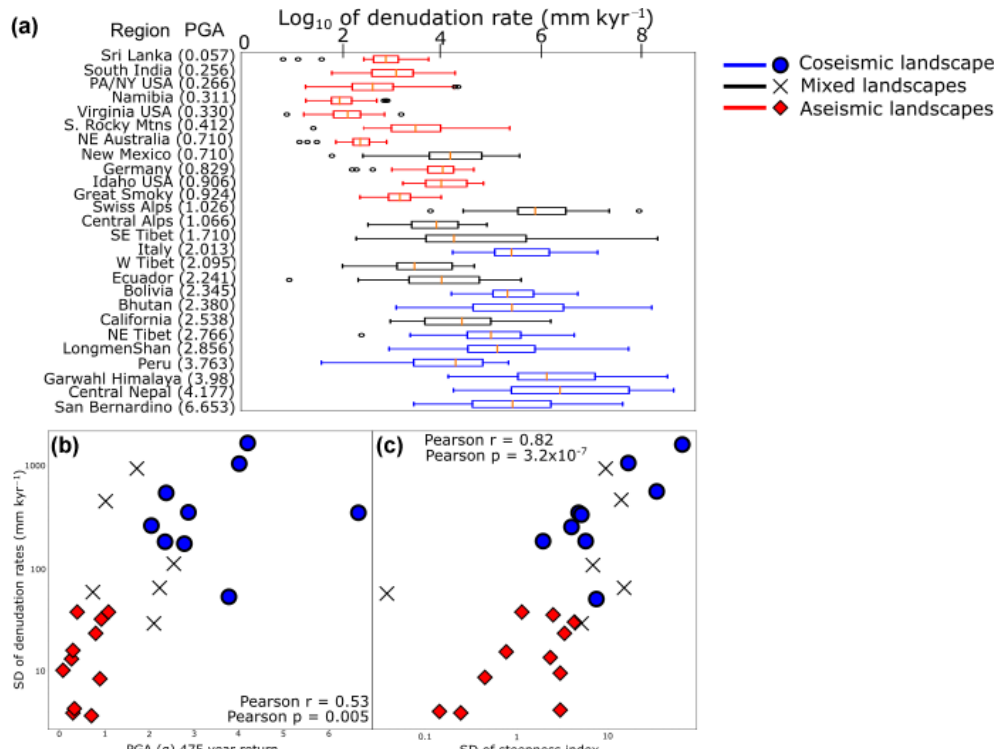
Figure 6. Reanalysis of detrital cosmogenic radionuclide derived denudation rates for mountain belts around the world compiled by Harel et al. (2016), in the context of peak ground acceleration and tectonic environment. (a) A box plot indicating the median (central orange line), quartiles (end of box) and the range (“the whiskers”) of denudation rates in the analysed localities ordered by their average seismicity (in brackets), defined as the maximum peak ground acceleration (PGA) of a 475-year return period. Points indicate values outside the range, ± 1 . 5 times the interquartile range. (b) Standard deviation (SD) of denudation rates for each mountain belt against seismicity represented by the 475-year return PGA (ms − 2 ). (c) Standard deviation of denudation rates for each mountain belt compared to the standard deviation of steepness indexes. The areas of highest variability are found in steep, tectonically active mountain